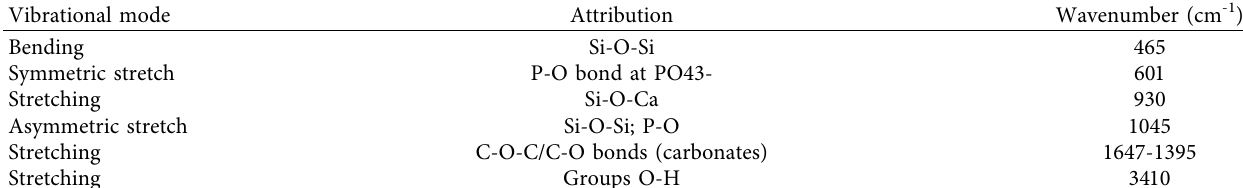
Table 1: Infrared frequencies and band assignments of the bone graft composite.